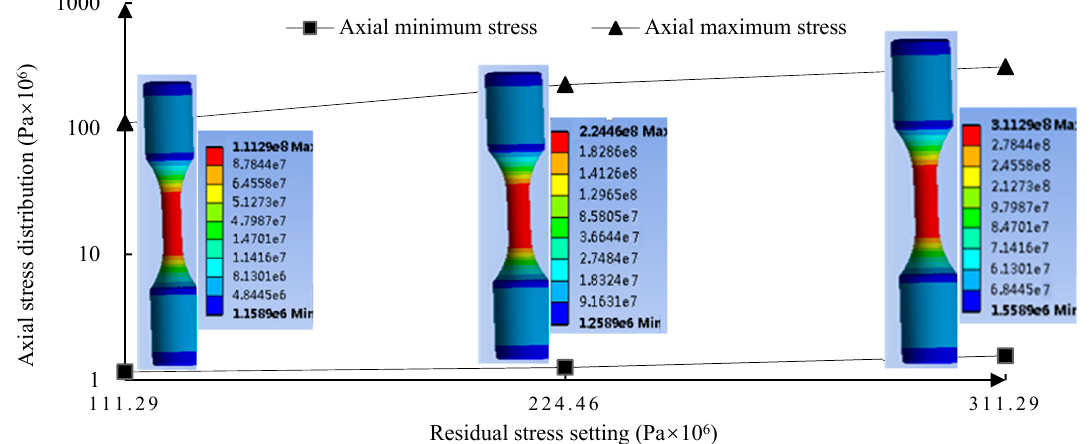
Figure 9. Stress distribution after normal stress is applied.